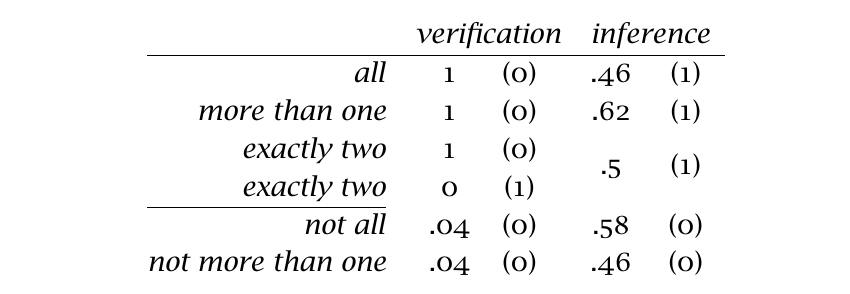
Table 3 : Rates of positive responses observed in Experiment 3